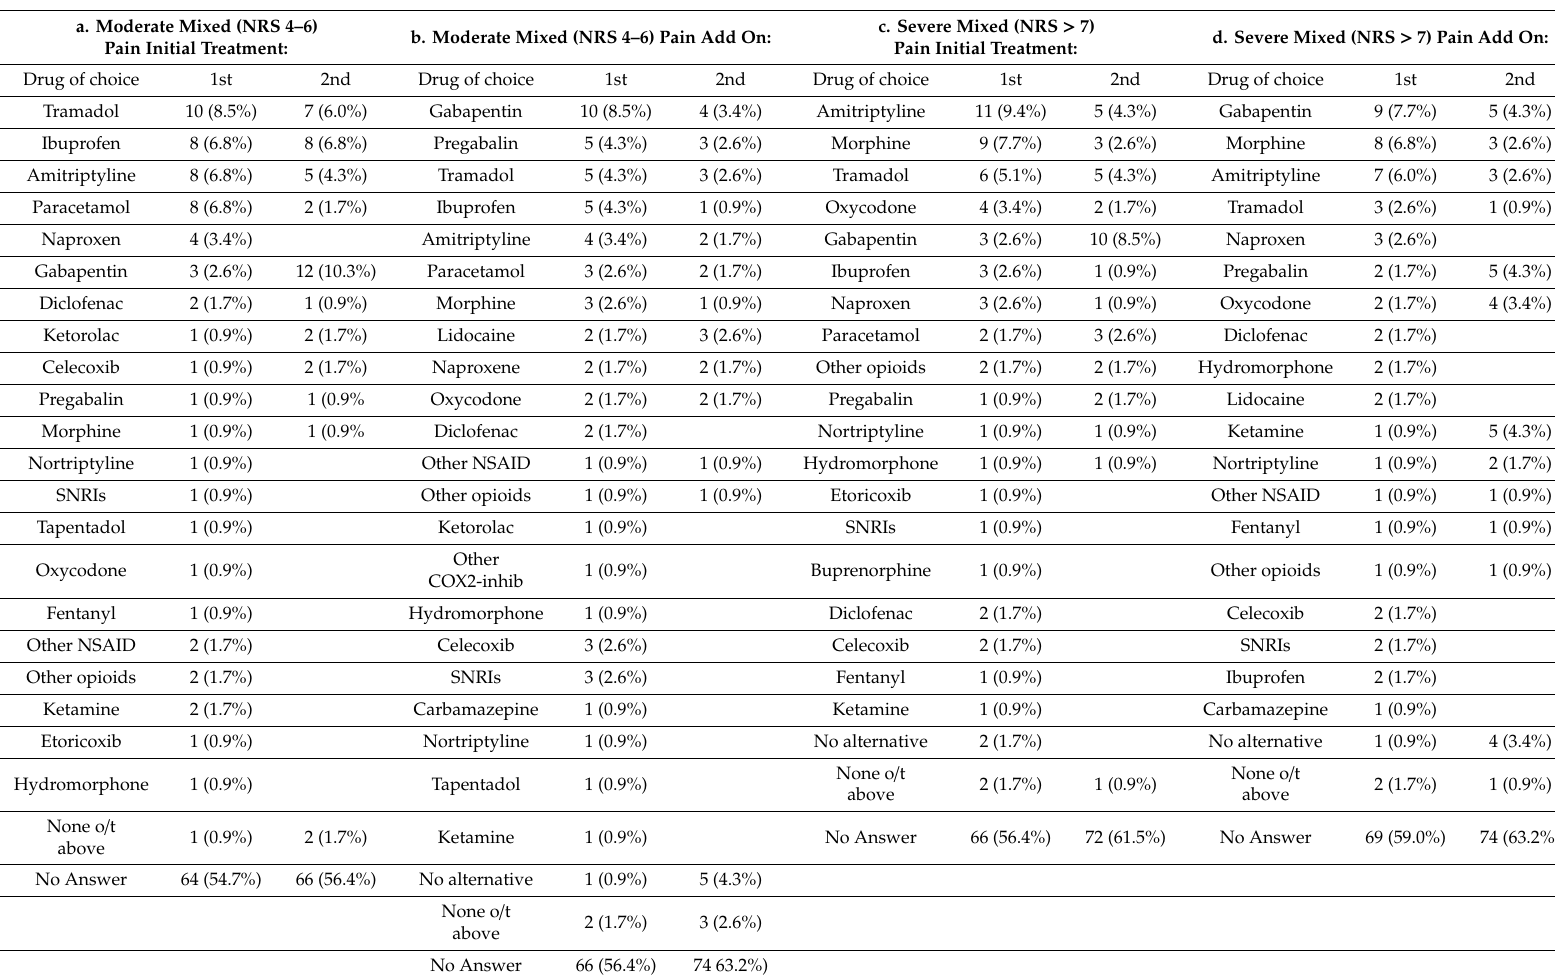
Table 6. Prevalences of first (and second) medication of choice and medication used as add-on in case of moderate and severe mixed